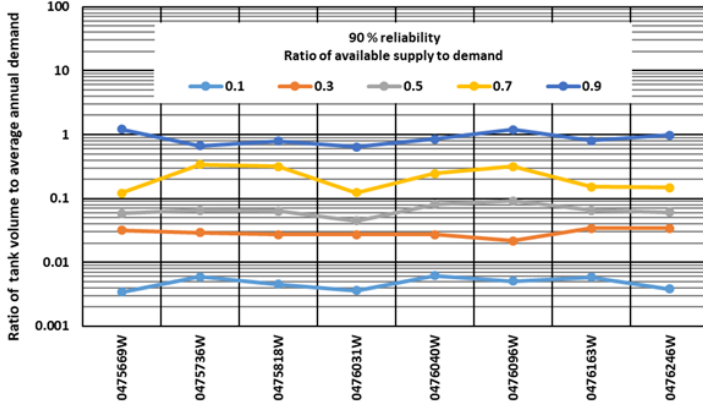
Figure 3. Typical variation of tank volume to demand ratio for different rainfall